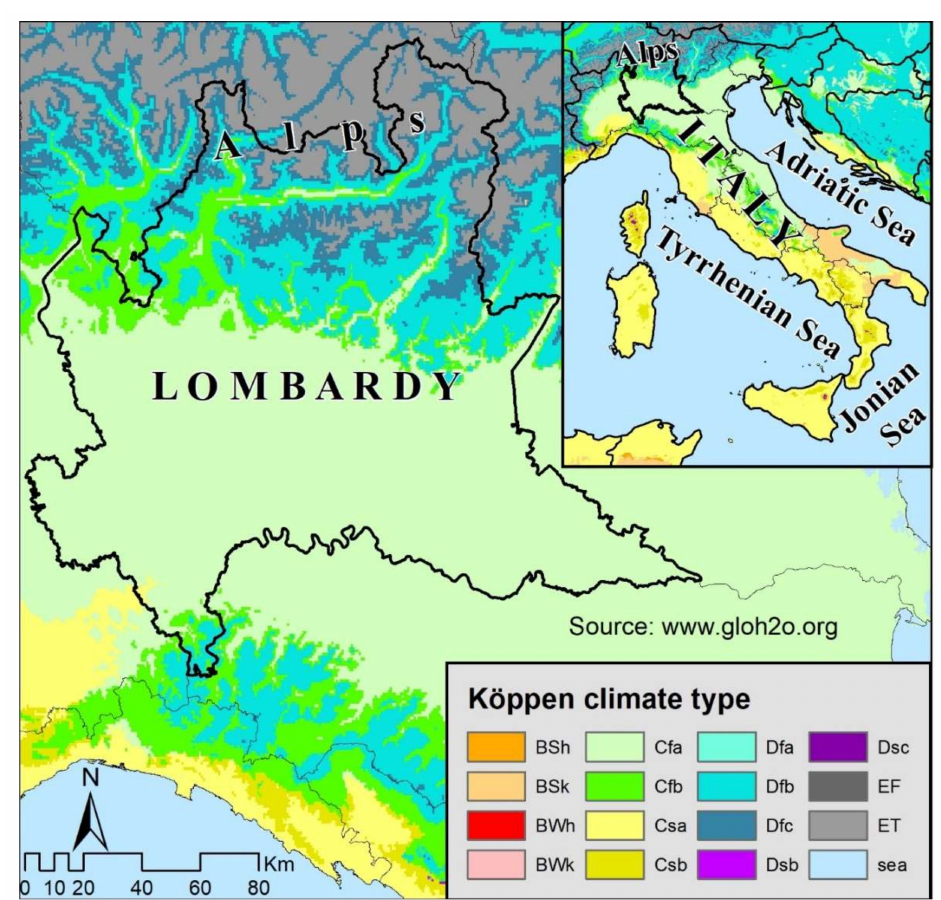
Figure 2. Climate map of Italy with evidenced Lombardy. For the codes, refer to Köppen-Geiger,